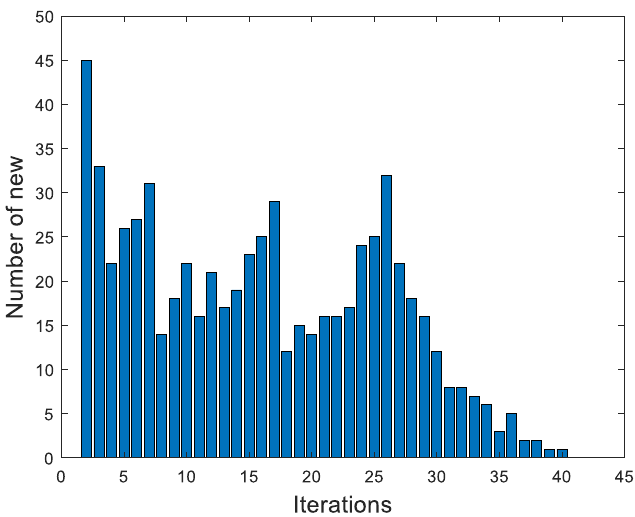
Figure 8. Graph of the number of new samples changing with the number of iterations. With the enrichment of the training sample set, the training model will also change. sample, and the accuracy change is shown in Figure